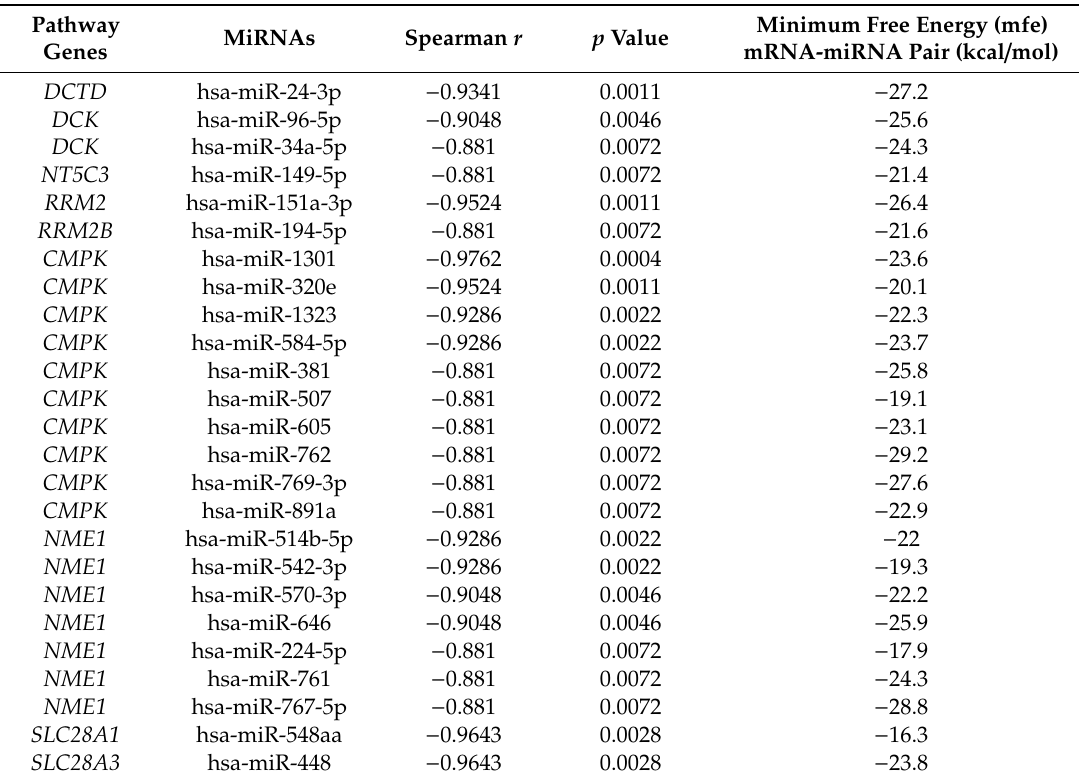
Figure 5. Validation of binding interactions between DCK and mRNA and has-miR-34a-5p by RNA EMSAs. RNA EMSA with cys5-labeled has-miR-34a-5p oligonucleotide and 2’-O-methyl modified and IRD-800 labeled DCK mRNA oligonucleotide. Lanes 1 and 2 show the mobility of the labeled mRNA or miRNA oligonucleotide. Lane 3 shows the mobility of the labeled has-miR-34a-5p oligonucleotide with DCK mRNA oligonucleotide. Lanes 4 and 6 show the mobility of labeled DCK mRNA oligonucleotide in presence of unlabeled excess specific competitor (has-miR-34a-5p) and excess unlabeled non-specific competitor (NC). Table 1. MiRNAs with significant negative association (as reflected by r value) with nucleoside analog pathway genes in AML Cell